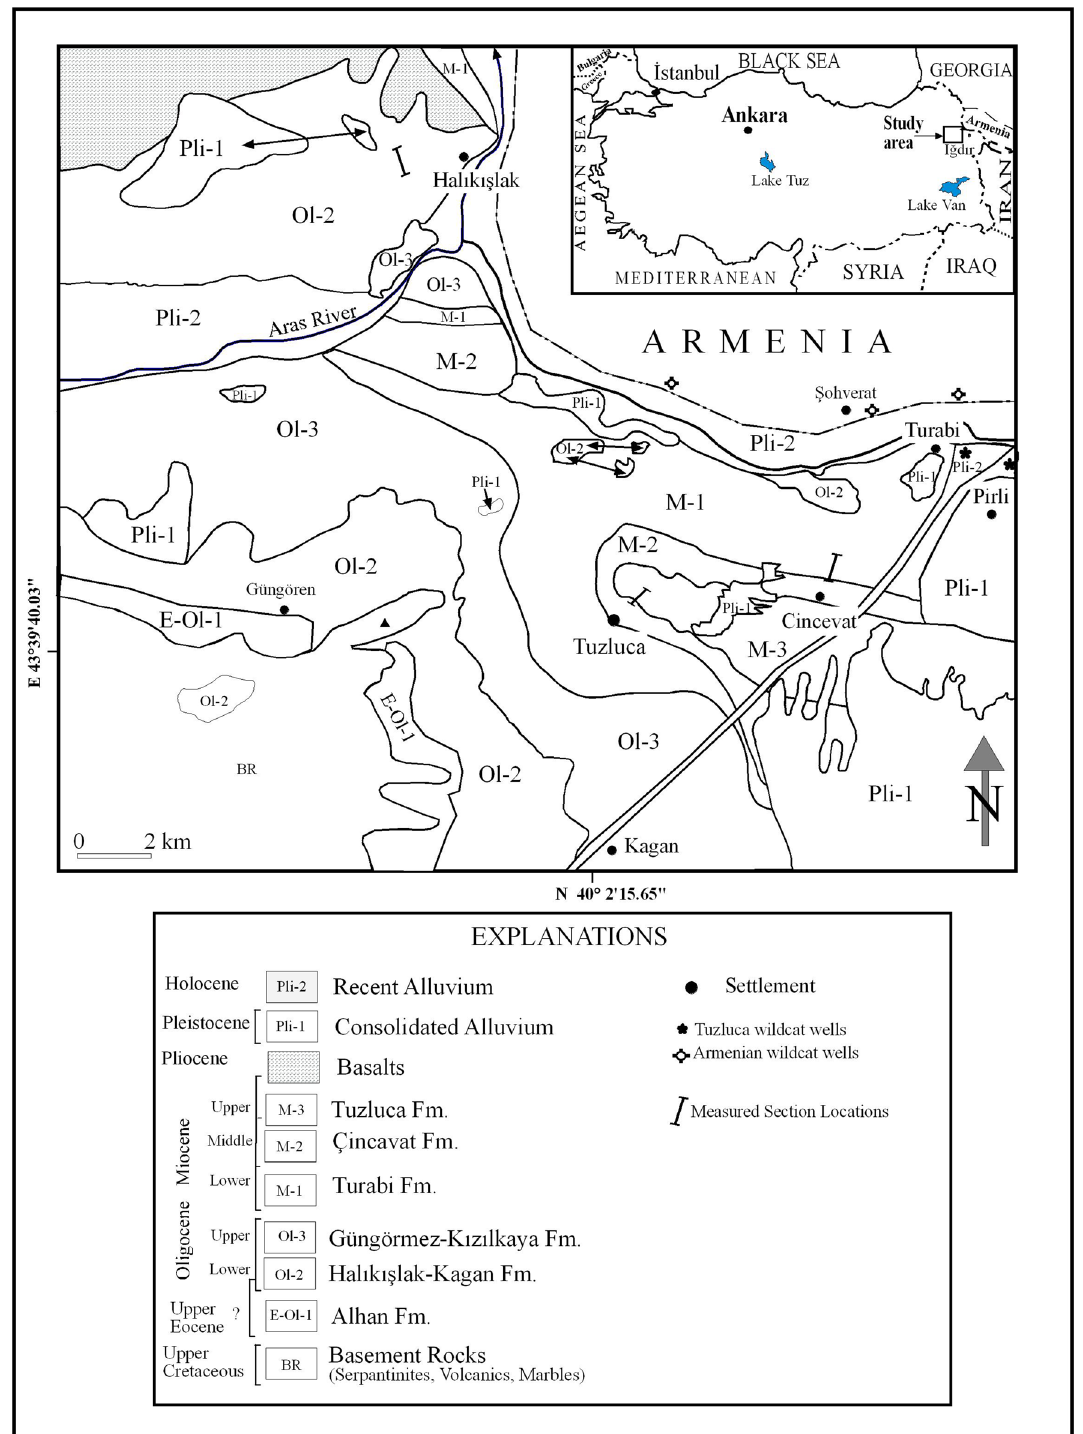
Fig. 2 Geological map of the Tuzluca area (revised from Şen et al. 2011; Varol et al.